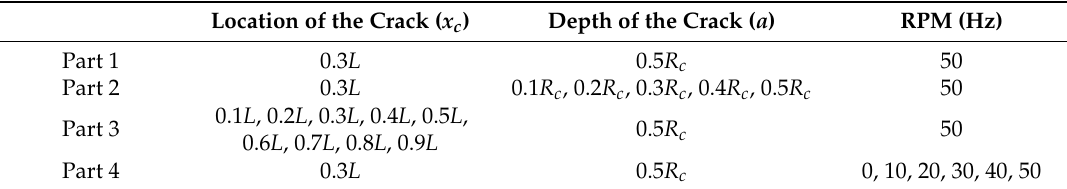
Table 1. The numerical and experiment